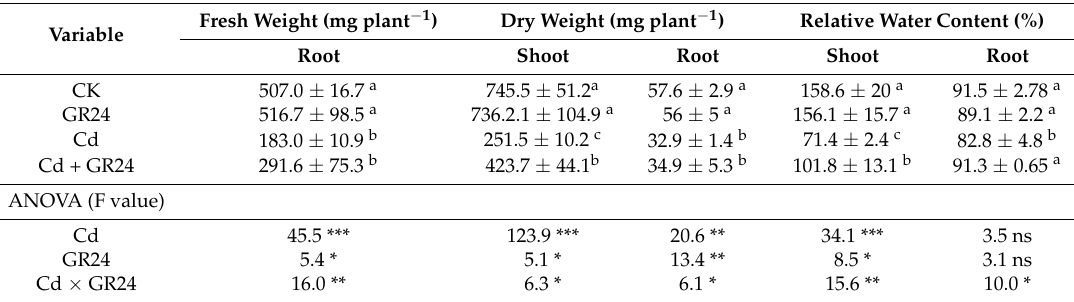
Table 1. Effects of GR24 on root and shoot biomass and root/shoot/plant relative water content of seedlings exposed to different